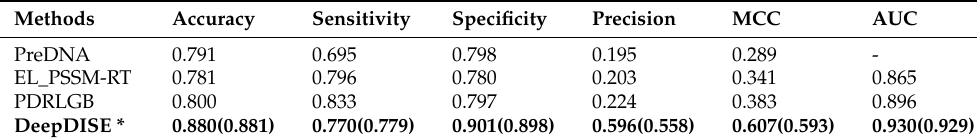
Table 3. Performance of DeepDISE compared with previous methods using PDNA224